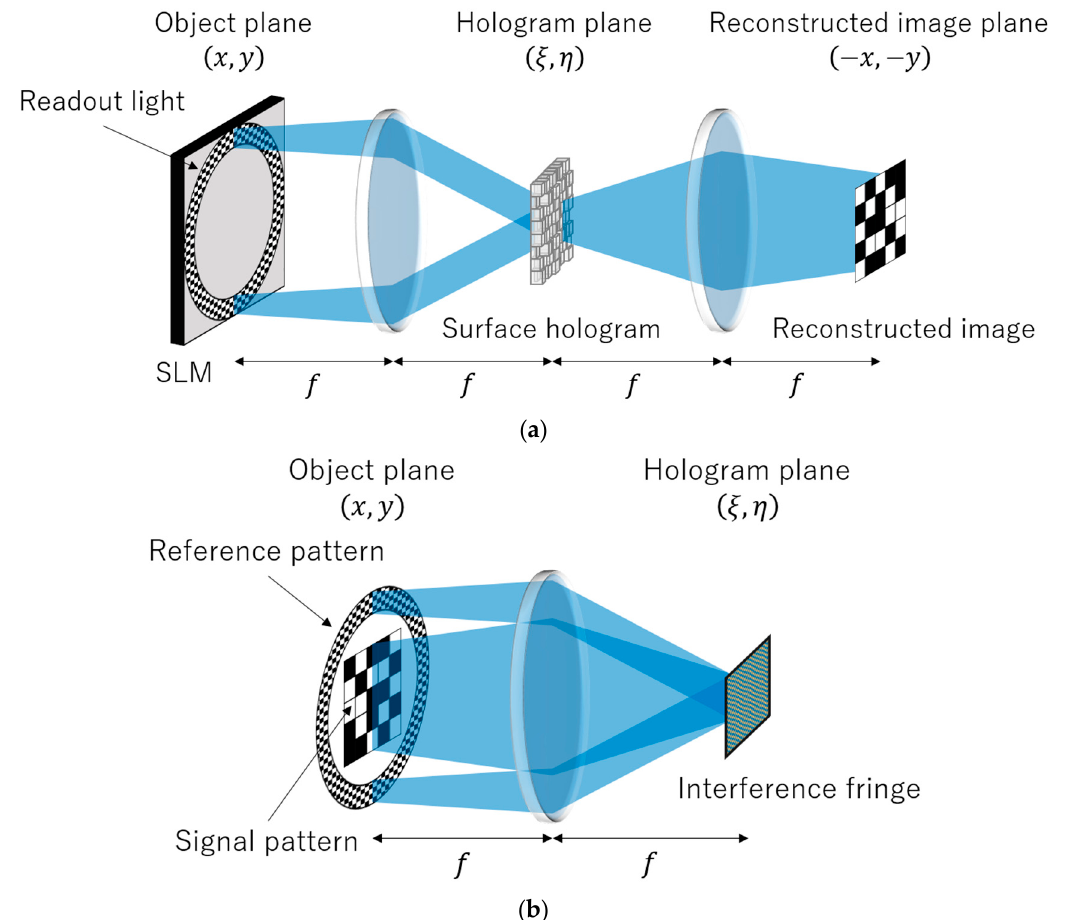
Figure 1. ( a ) Schematic of the optical system in case of reconstruction; ( b ) schematic of the optical system assumed for calculation in the case of hologram design.